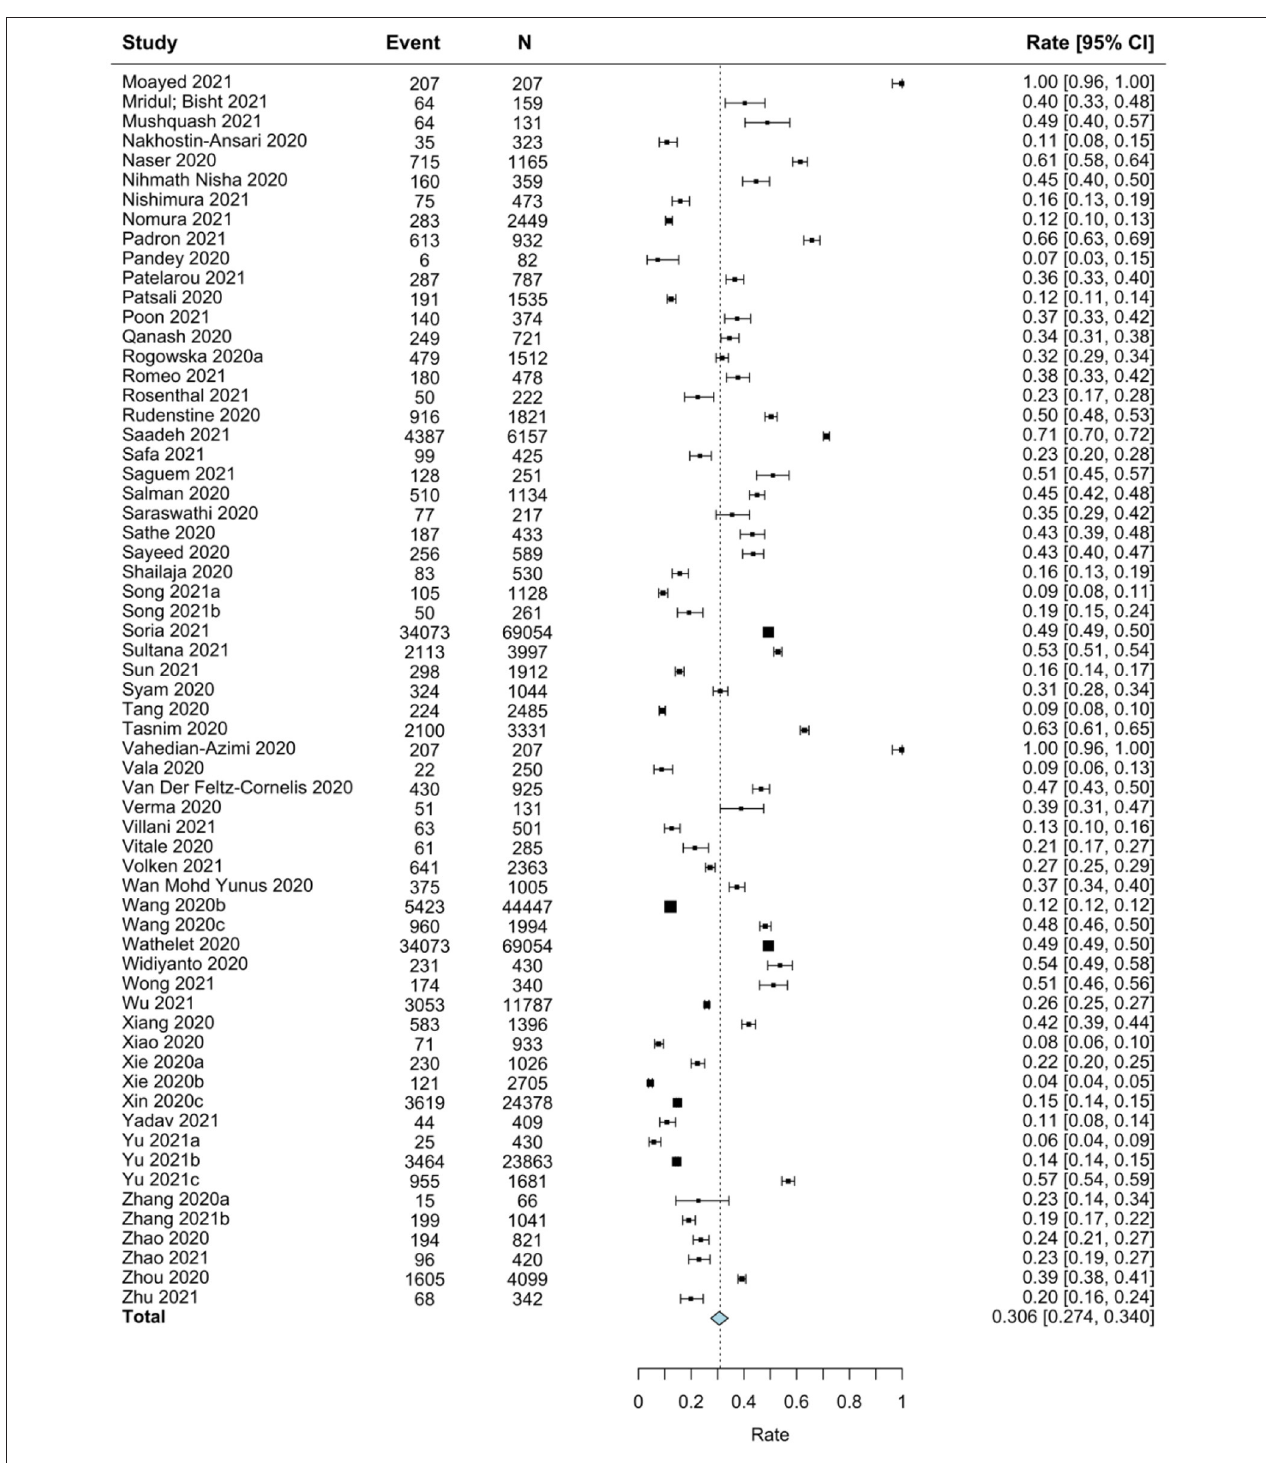
FIGURE 2 | Forest plot for the meta-analysis on prevalence rates of depression in